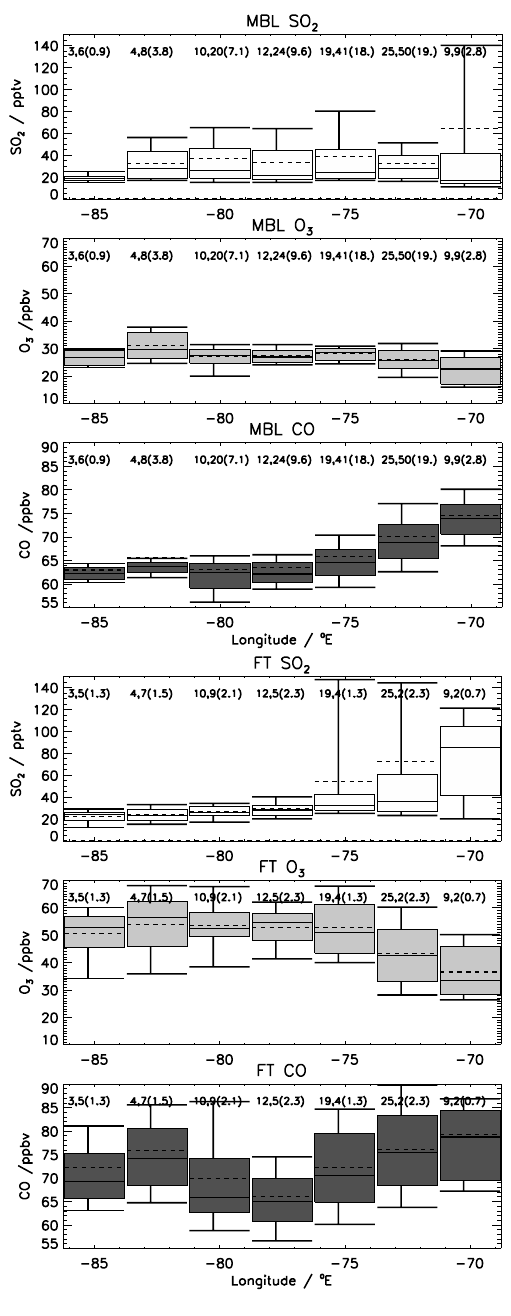
Fig. 5. Sulphur dioxide (top panels), ozone (centre panels) and car- bon monoxide (lower panels) concentration statistics in the MBL (left panels) and the FT (right panels) gridded into 2.5 degree lon- gitudinal zones along the 20 ◦ South parallel averaged from aircraft measurements during VOCALS-REx. For each zone, thick centre lines indicate the median, dashed lines indicate the mean, boxes indicate upper and lower quartiles with upper and lower decile whiskers. Plotted above each longitude zone and for each panel, numbers before the comma indicate number of flights contributing to each statistic, followed by the number of straight and level runs, with the total sampling time in decimal hours in